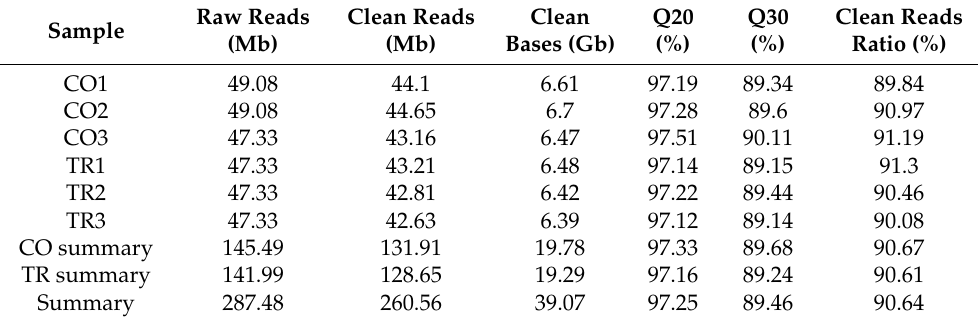
Table 4. Summary of sequence